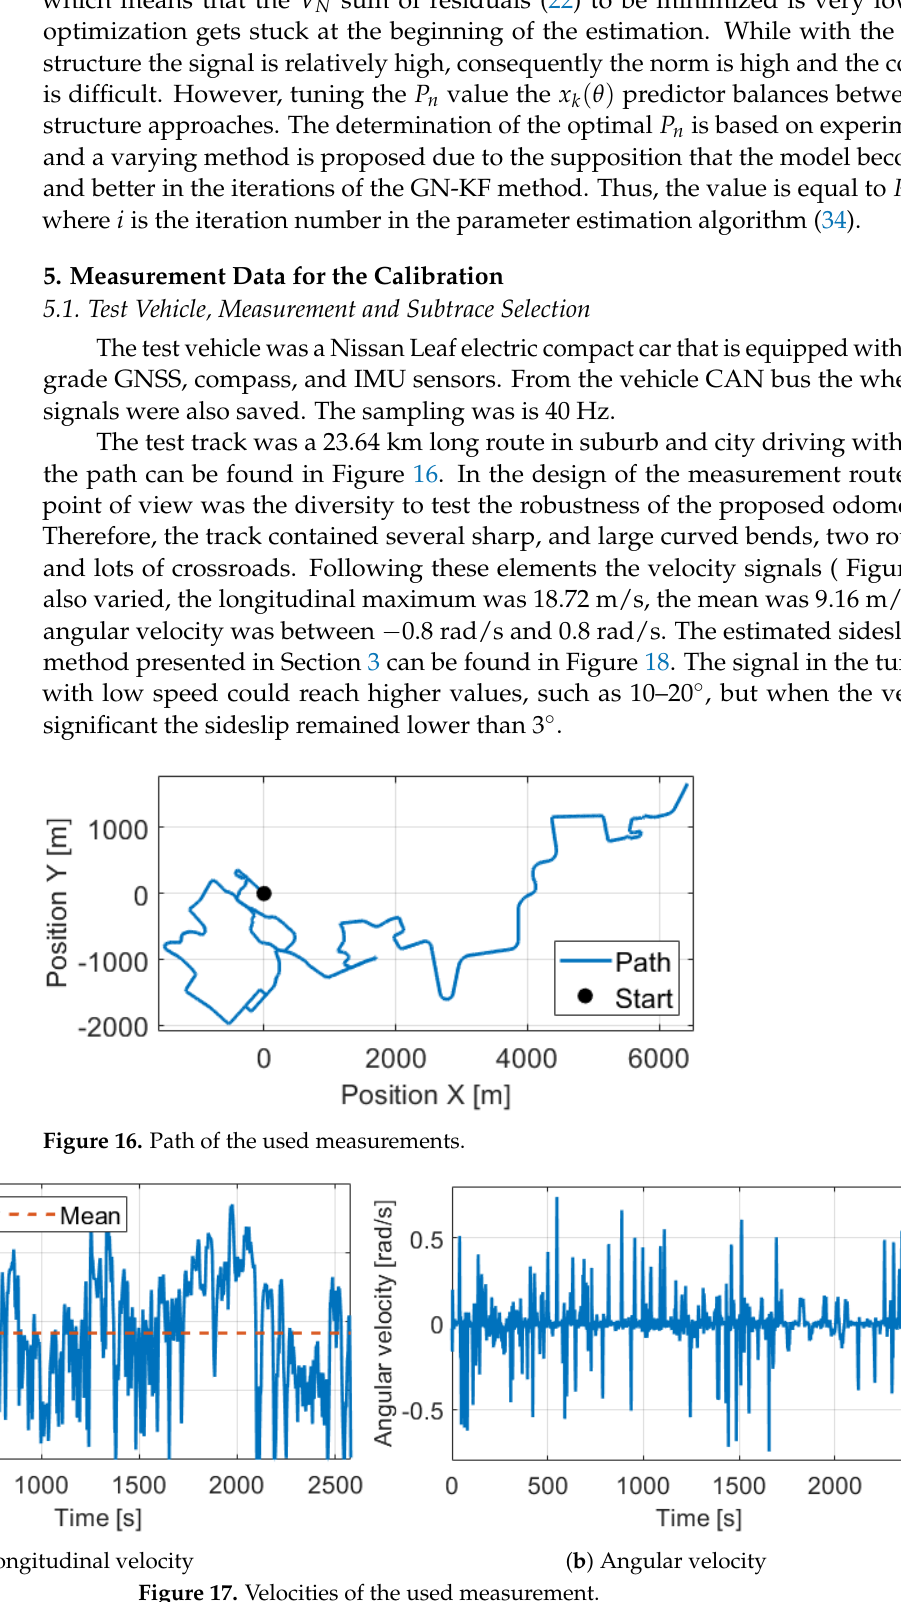
Figure 17. Velocities of the used